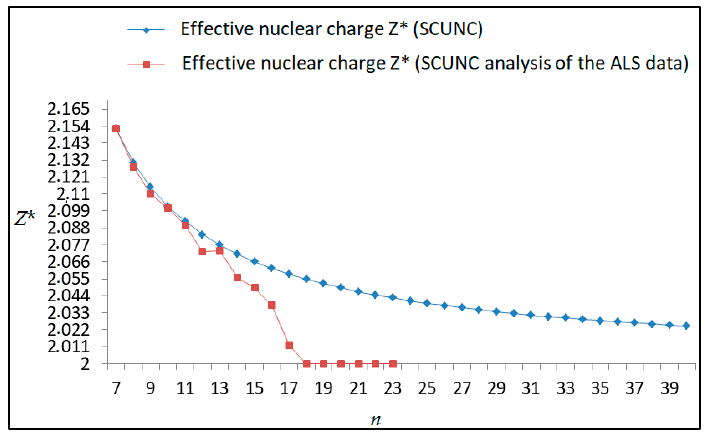
Figure 22. Variations of the effective nuclear charge Z* with the principal quantum number n for the 4 s 2 4 p 2 ( 1 D 2 ) ns ( 2 D ) Rydberg series originating from 2 D ° 3/2 metastable state of Se + converging to the 1 D 2 series limits in Se 2+ . Table 12. Energy resonances ( E ), quantum defect ( δ ) and effective charge ( Z *) of the 4 s 2 4 p 2 ( 3 P 2 ) nd Ry- dberg series originating from the 4 s 2 4 p 3 4 S ° 3/2 ground state of Se + converging to the 3 P 2 series limit in Se 2+ . The present results (SCUNC) are compared with the experimental data from ALS measurements [6]. f 1 ( 3 P 2 ; 4 S ° 3/2 ) = − 0.379 ± 0.042 with ν = 11.